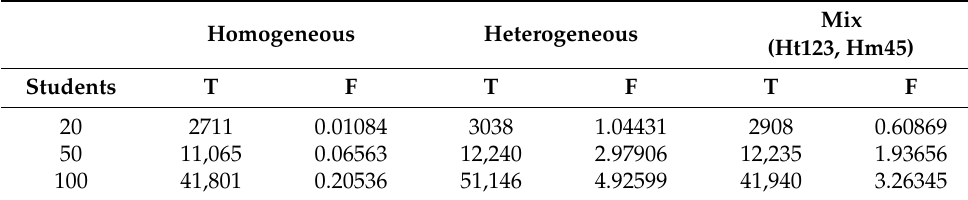
Table 10. Results of the 5-student group formation (time (T) in milliseconds, fitness value (F)).